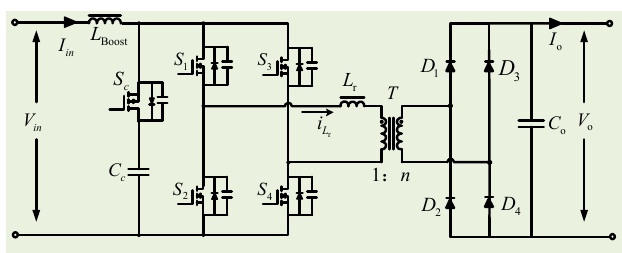
Figure 1. Topology of an isolated full-bridge boost converter (BFBIC).